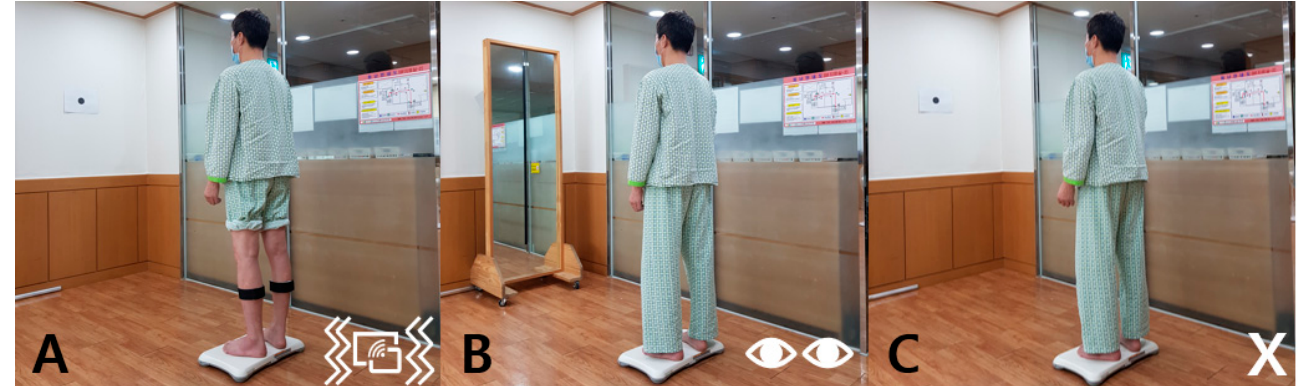
Figure 2. Various bio-feedback conditions ( A ) Pressure sensor-based vibrotactile biofeedback, ( B ) Visual biofeedback providing posture information, ( C ) Normal standing position with no biofeedback)